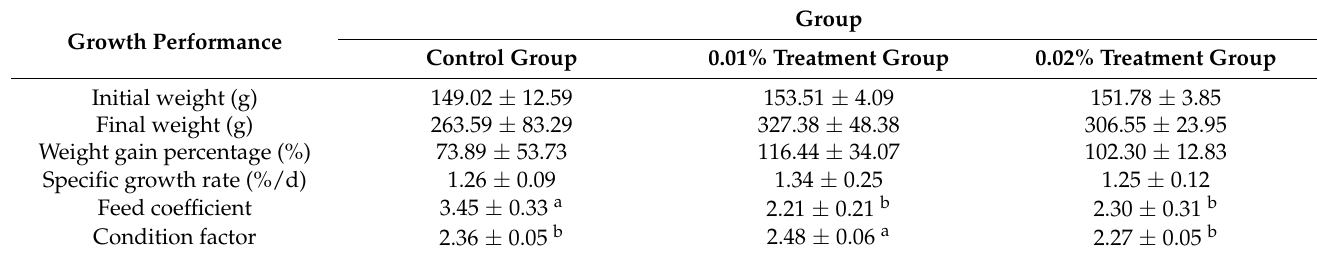
Table 3. Growth performance of Seriola dumerili at different levels of curcumin in feed.